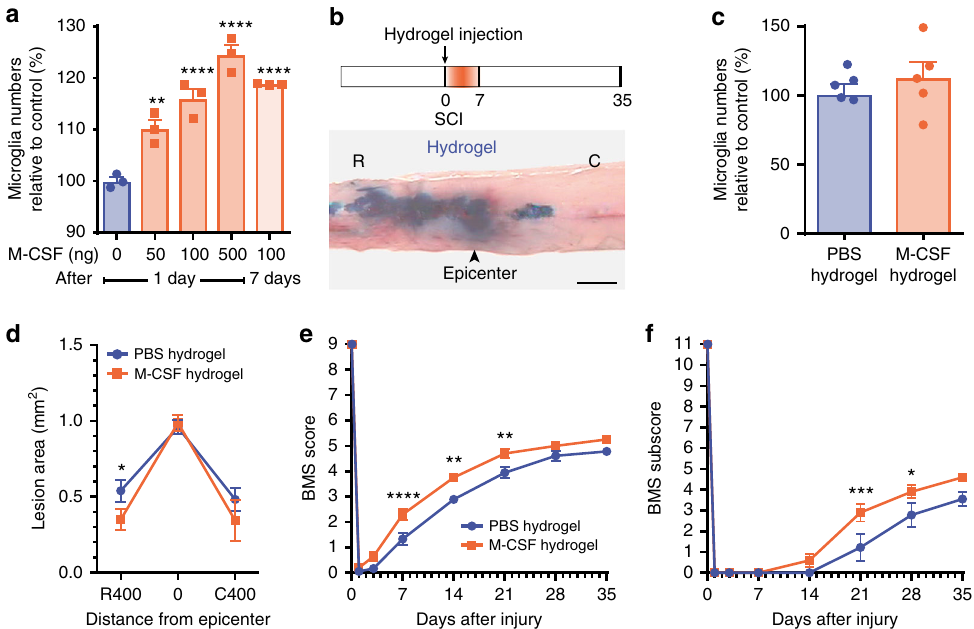
Fig. 9 Hydrogel delivery of M-CSF at the site of SCI boosted microglial proliferation and enhanced functional recovery. a Quanti fi cation of the number of microglia (CD11b + P2ry12 + ) in the thoracic spinal cord following intra-cisterna magna injection of recombinant murine M-CSF at various doses ( n = 3 mice per group). b Schematic of the experimental design showing the timeline of spinal cord contusion (SCI), hydrogel injection, behavioral testing using the Basso Mouse Scale (BMS), and sacri fi ce. Below the schematic is a picture showing how much a hydrogel loaded with Evans blue spreads following subdural injection at the site of SCI. c Quanti fi cation of the number of microglia (TdT + ) at the lesion epicenter at 7 days post-injury (dpi) in Cx3cr1 creER :: R26 - TdT mice treated with either M-CSF-based (orange bar) or PBS-based (blue) hydrogels ( n = 5 mice per group). d Quantitative analysis of the total lesion